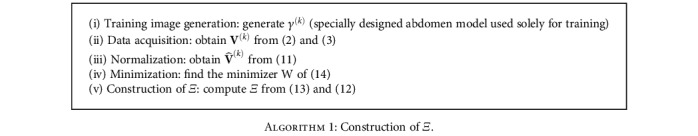
 Construction of Ξ.